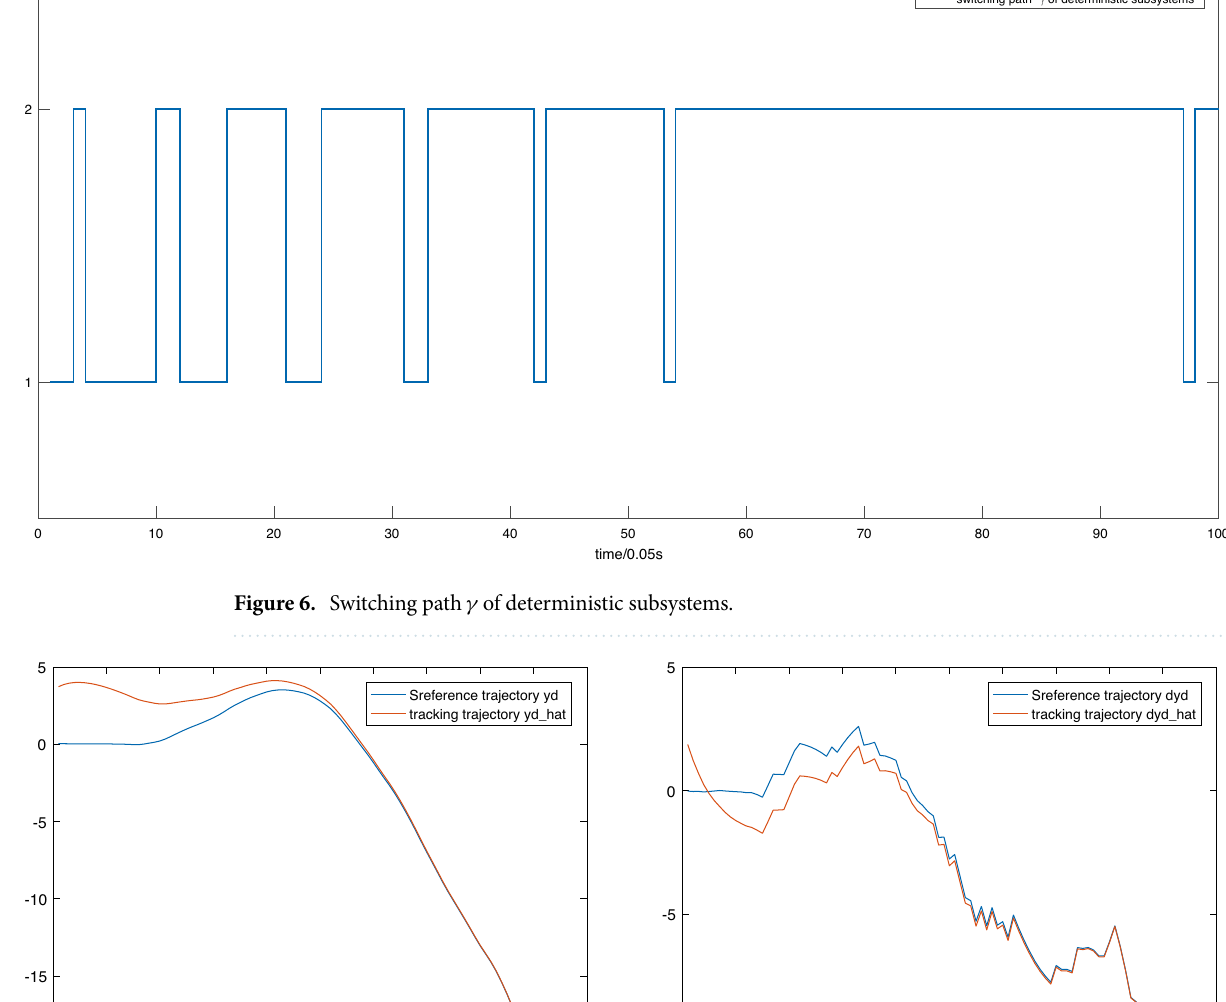
Figure 7. Tracking effect of reference